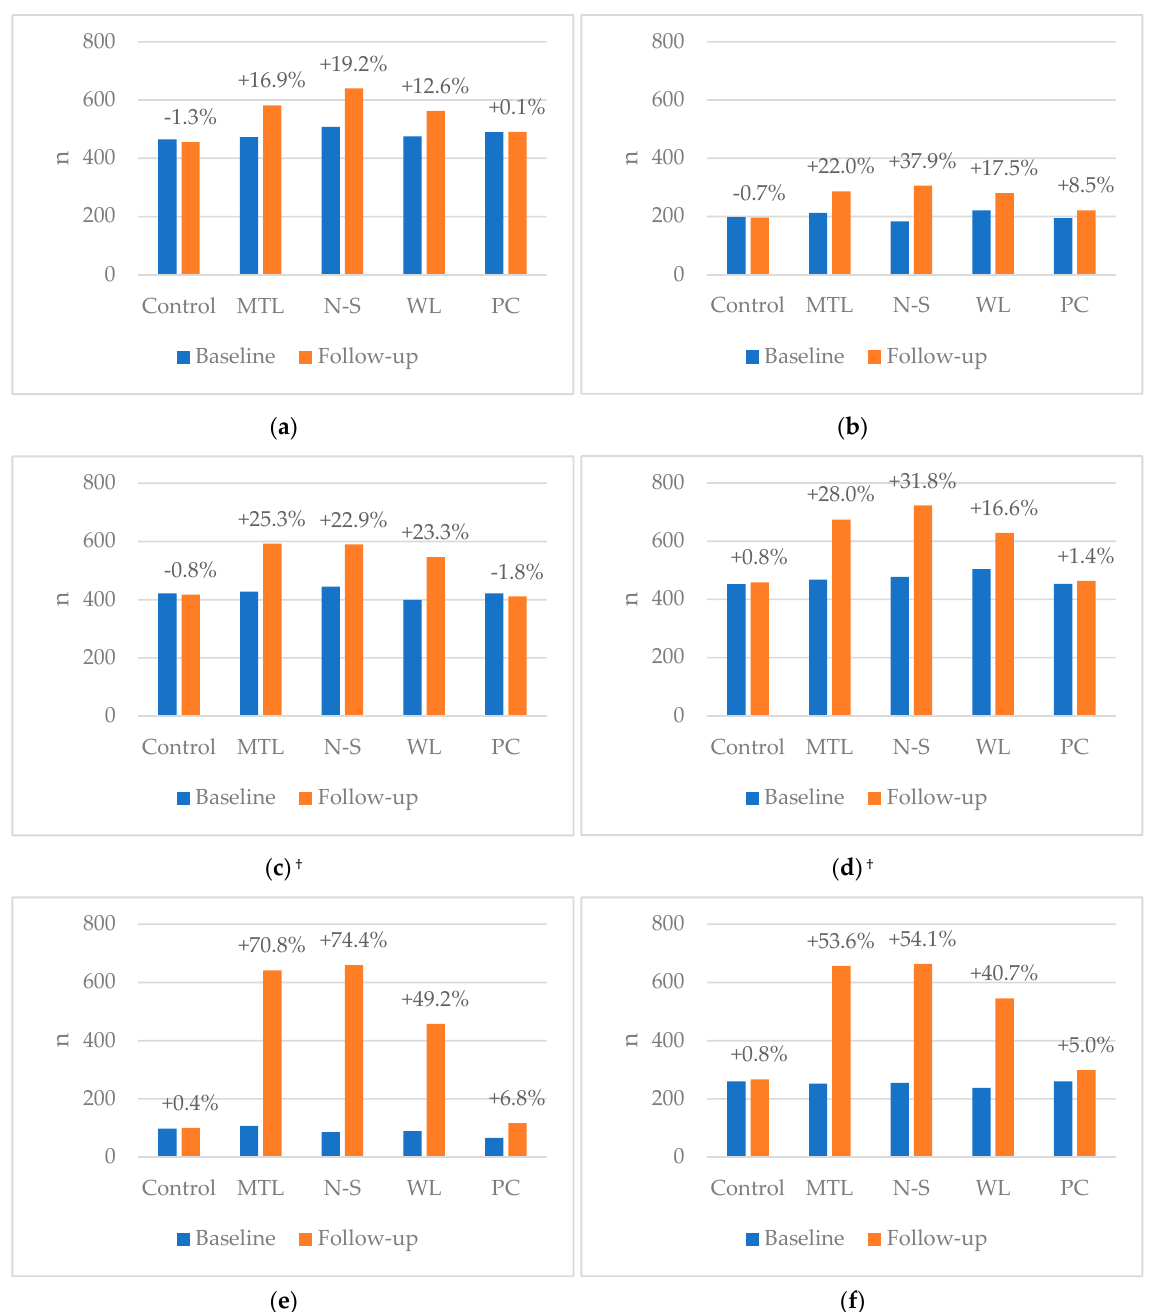
Figure 3. Number of participants who correctly ranked products at baseline and follow-up, by FOPL group and product category: ( a ) Pizza; ( b ) Drink; ( c ) Cake; ( d ) Crisps; ( e ) Yoghurt; ( f ) Breakfast cereal. † Cake and crisps categories had no products qualify for Positive Choice tick. MTL: Multiple Traffic Lights; N-S: Nutri-Score; WL: Warning label; PC: Positive Choice tick.